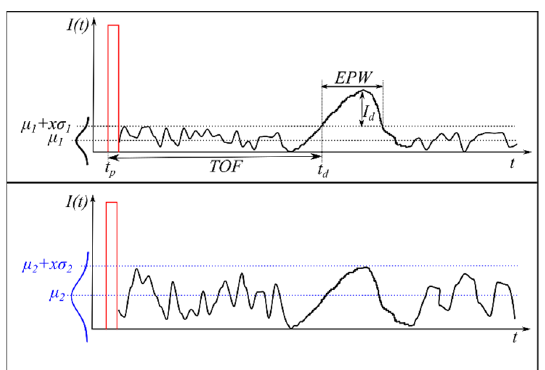
Figure 2. Relation between TOF and intensity for a received pulse. If the noise level increases (blue) no detection is registered. The sent pulse (idealized) is shown in red and the received signal in black.